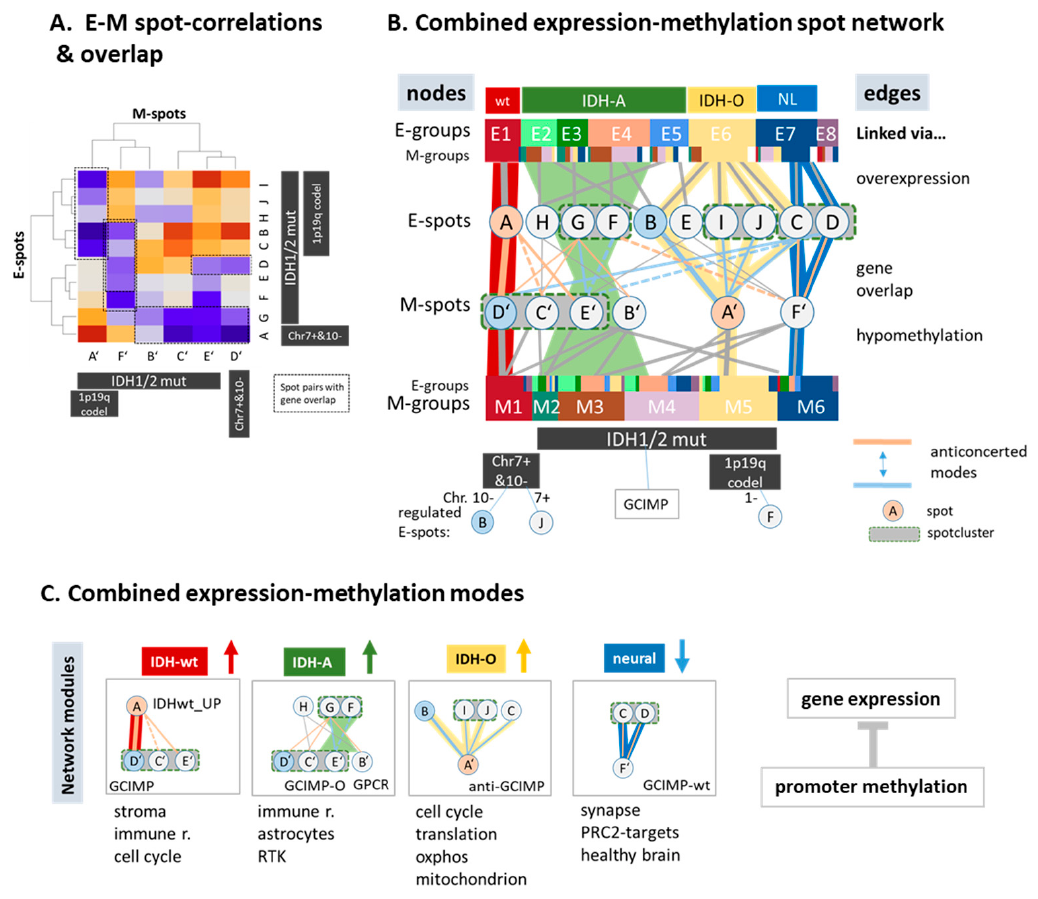
Figure 7. Combined view of the expression and methylation landscapes: ( A ) The network between expression and methylation spots (see Figure S20 for details) was obtained on the basis of gene overlap between the spots and mutual correlations between the spot profiles. ( B ) The correlation map between expression and methylation spot values revealed negatively correlated M–E spot pairs with considerable gene overlap (see also Figure S20). ( C ) The network in part A divided into four main coupled regulatory modules in the four consensus